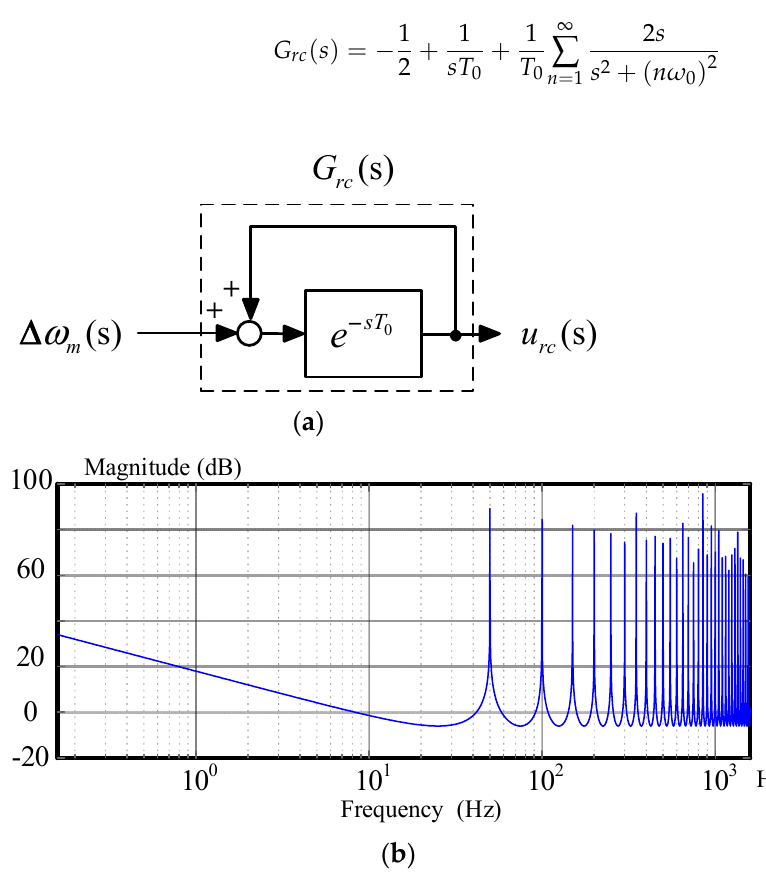
Figure 2. The continuous-time of the periodic signal generator: ( a ) internal model; ( b ) spectrum diagram.